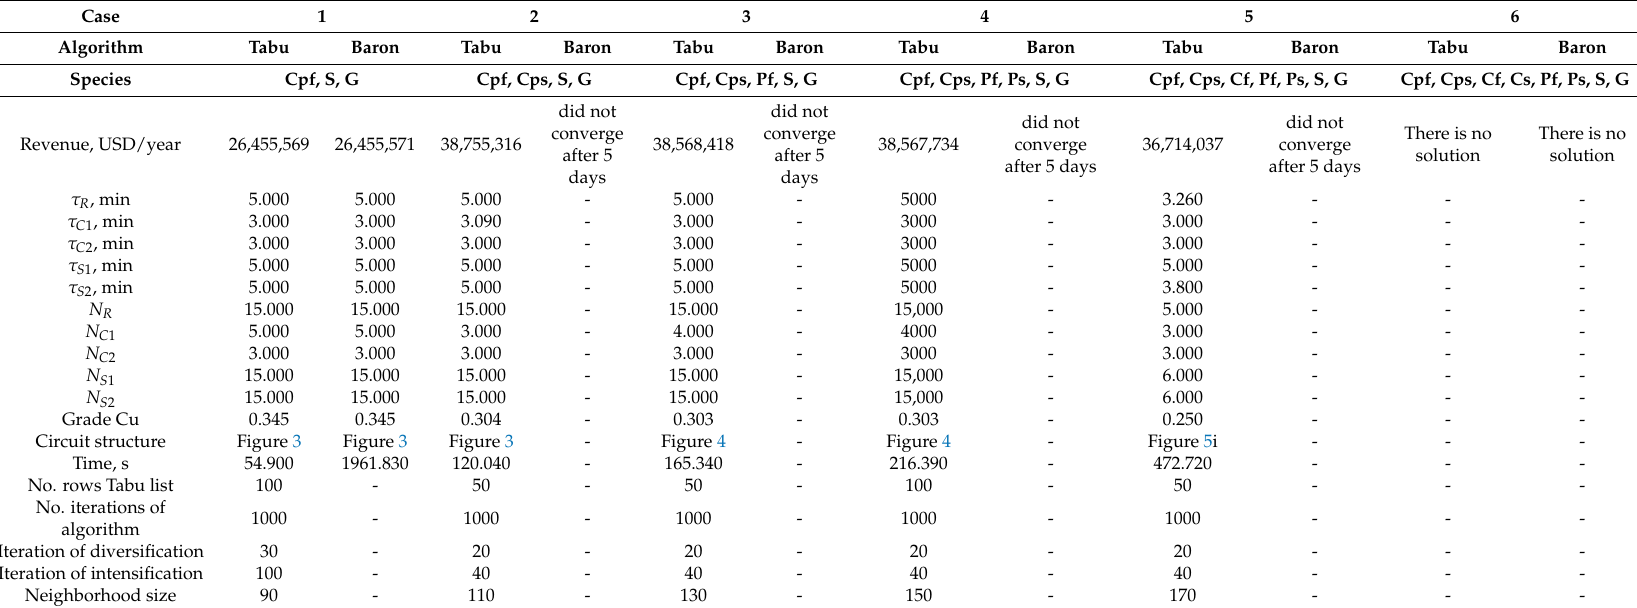
Table 5. Benchmarking between the Tabu algorithm and the Baron solver (revenues; reduced mathematical model; Pf = pyrite fast, Ps = pyrite